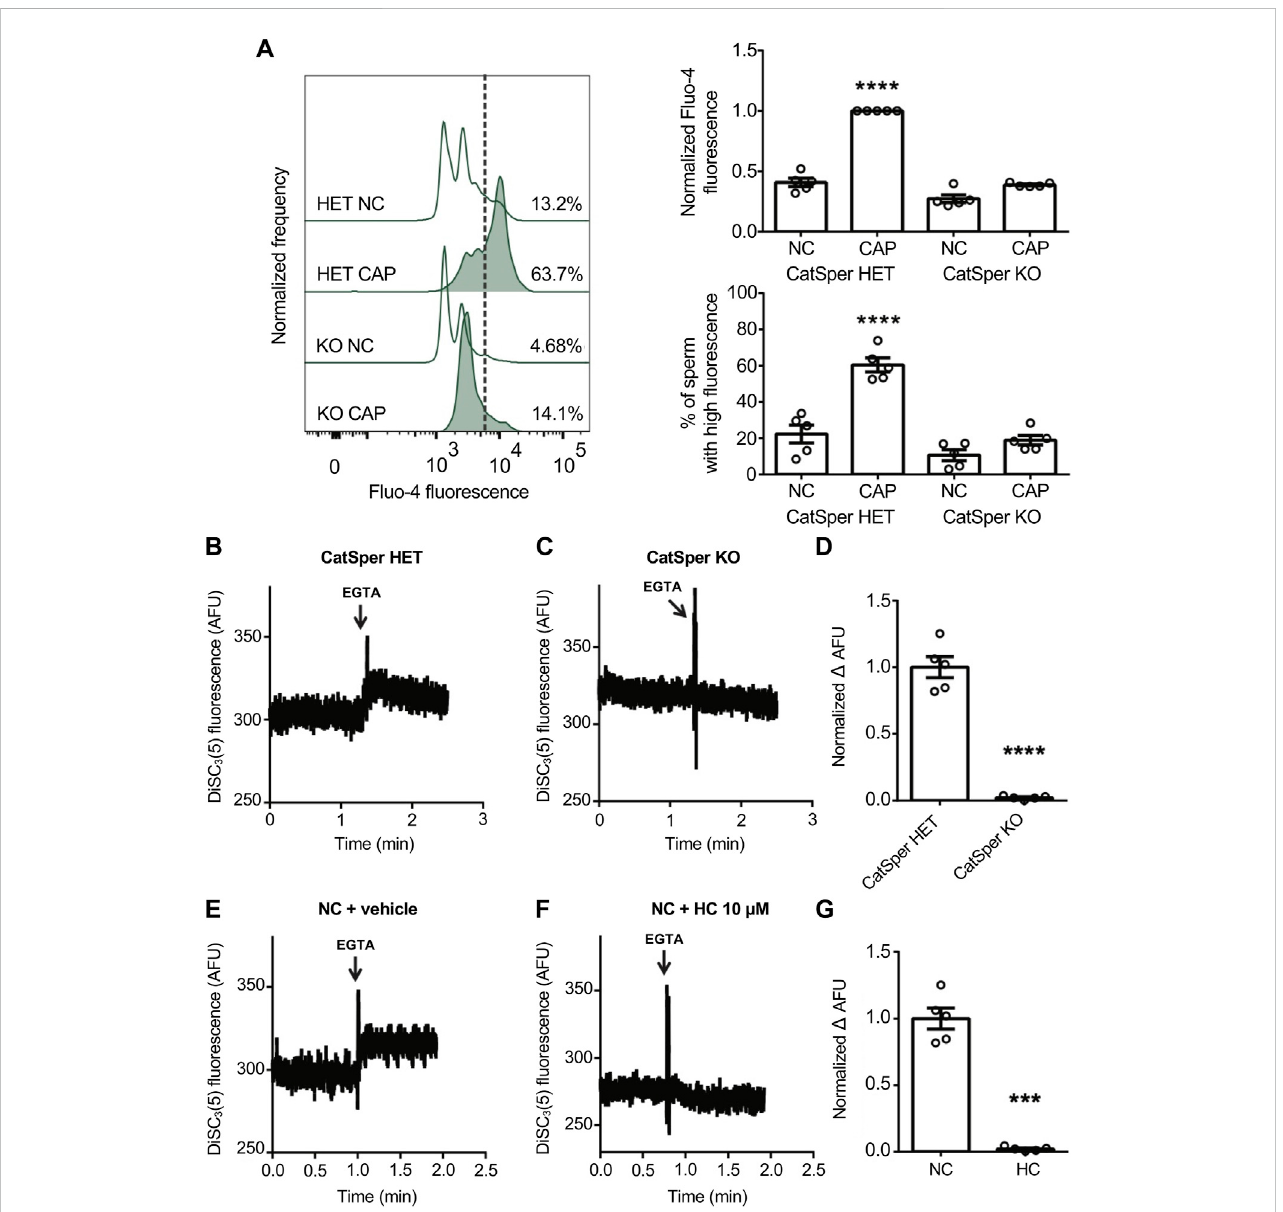
FIGURE 1 CatSper activitywasanalyzed bymeasuring Eminapopulationassayby spectro fl uorometry, where extracellular DiSC 3 (5) fl uorescence wasdetermined. EffectofCa 2+ removalbyEGTA3.5 mMadditiononNCspermloadedwith1 μ MDiSC 3 (5). (A) Spermincubatedfor90 minundercapacitatingconditions(CAP) or non-capacitating conditions (NC) were analyzed. Representative histograms of normalized frequency vs. Fluo-4 fl uorescence of non-PI-stained sperm (live), with the corresponding percentage of sperm that increased Fluo-4 fl uorescence, are shown. Normalized median fl uorescence intensity, compared with the control condition (CatSper1 HET CAP), of Fluo-4. The percentage of sperm that responds by increasing the [Ca 2+ ] i was established in the CAP control condition (CatSper1 HET CAP) and extrapolated to the other conditions (dashed line). Values represent the mean ± SEM of 5 independent experiments. Two-way ANOVA showed a signi fi cant interaction (genotype × medium), P interaction < 0.001. **** p < 0.0001 represents statistical signi fi cance between control (CatSper1 HET CAP condition) and all other conditions. Sidak ’ s multiple comparisons test was performed. (B, C) Representative Em recordings are shown: DiSC 3 (5) fl uorescence traces (AFU: arbitrary fl uorescence units) through time in CatSper1 HET (B) and CatSper1 KO (C) sperm. (D) Summary of normalized Δ AFU after EGTA addition (F EGTA ) and before (resting: F R ) compared to the mean obtained in the control condition (CatSper1 HET). Data represents the mean ± SEM of 5 independent experiments. **** p < 0.0001 represents statistical signi fi cance vs. control (CatSper1 HET). Unpaired t -test wasperformed. (E,F) RepresentativeEmrecordingsareshown:DiSC 3 (5) fl uorescencetraces(AFU,arbitrary fl uorescenceunits)throughtimeincontrol(NC+ vehicle) (E) and10 µMHC-056456 (F) treatedsperm. (G) Normalized Δ AFUafterEGTAaddition(F EGTA )andbefore(resting:F R )comparedtothemeanobtained in the control condition (NC + DMSO). Data represents the mean ± SEM of 5 independent experiments. *** p < 0.001 represents statistical signi fi cance vs. control (NC + DMSO). Paired t -test was performed.